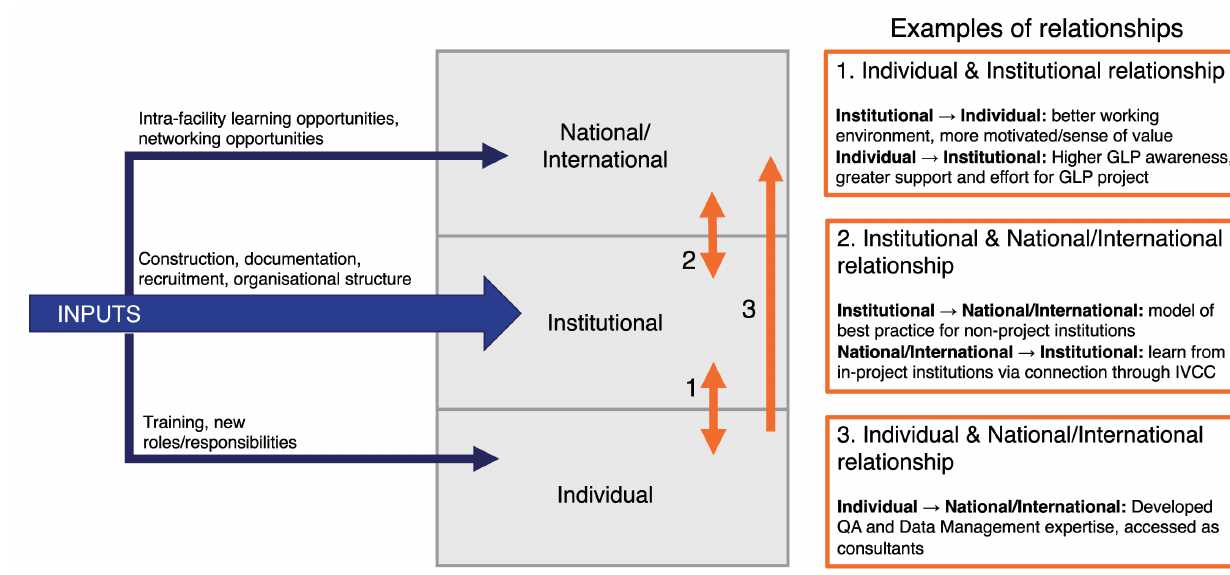
Figure 2. Illustration of inputs for achieving GLP certification at the individual, institutional, and national/international level, and effect relationships between these